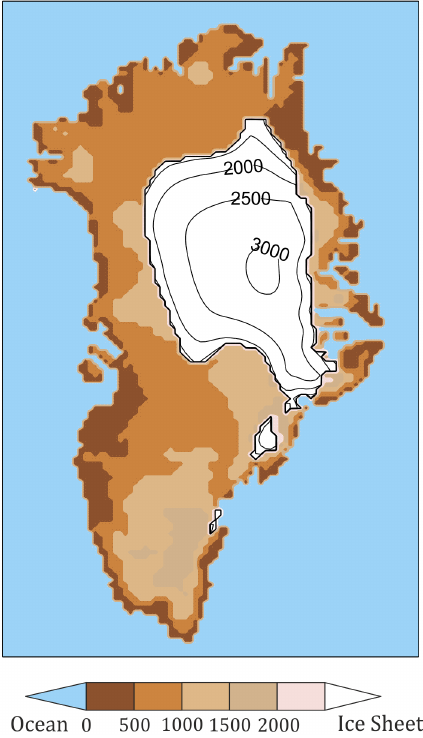
Figure 1. The PRISM3 Greenland ice sheet as simulated by BA- SISM (Hill, 2009; Dowsett et al., 2010). The forcing climatol- ogy for this ice sheet reconstruction is a HadAM3 simulation with PRISM2 boundary conditions (as described in Salzmann et al., 2008).